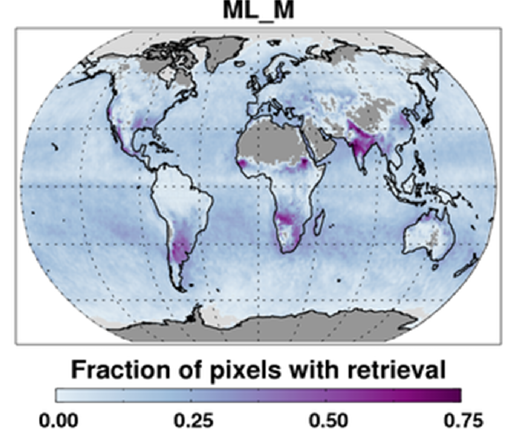
Figure 11. 1 ◦ × 1 ◦ retrieval fraction provided by the ML_M product during Spring